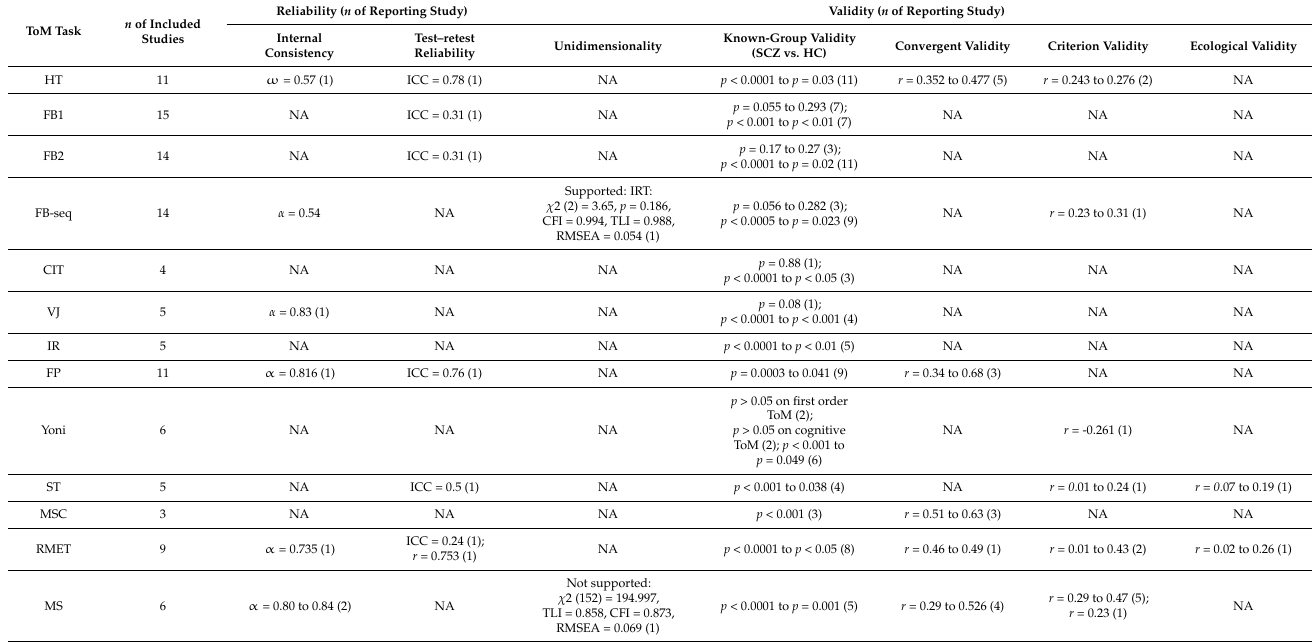
Table 3. Psychometric properties of each type of ToM